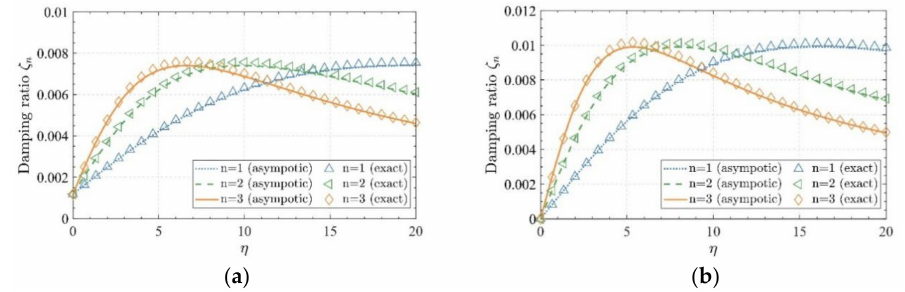
Figure 3. Comparison of asymptotic and numerical solutions with K = 300, ϕ = 0.5, x 1 / L = 0.01, x 2 / L = 0.02 and: ( a ) k s = 0; ( b ) k s =